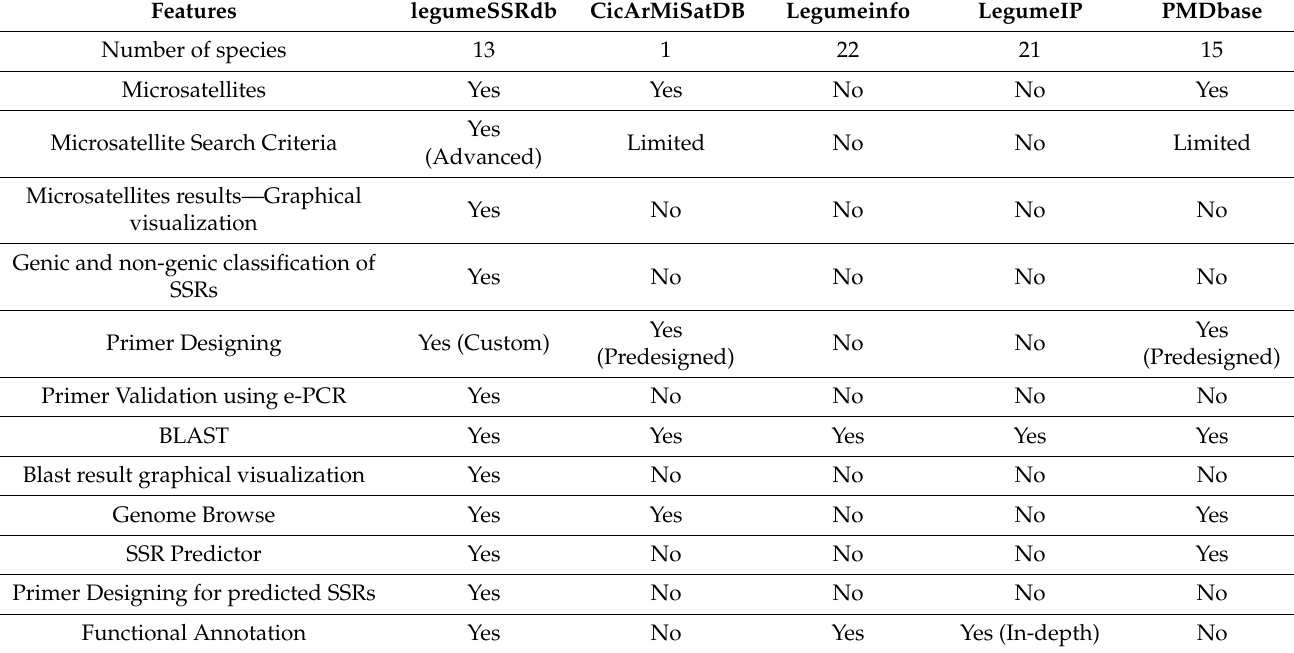
Table 3. Comparison of legumeSSRdb with other related